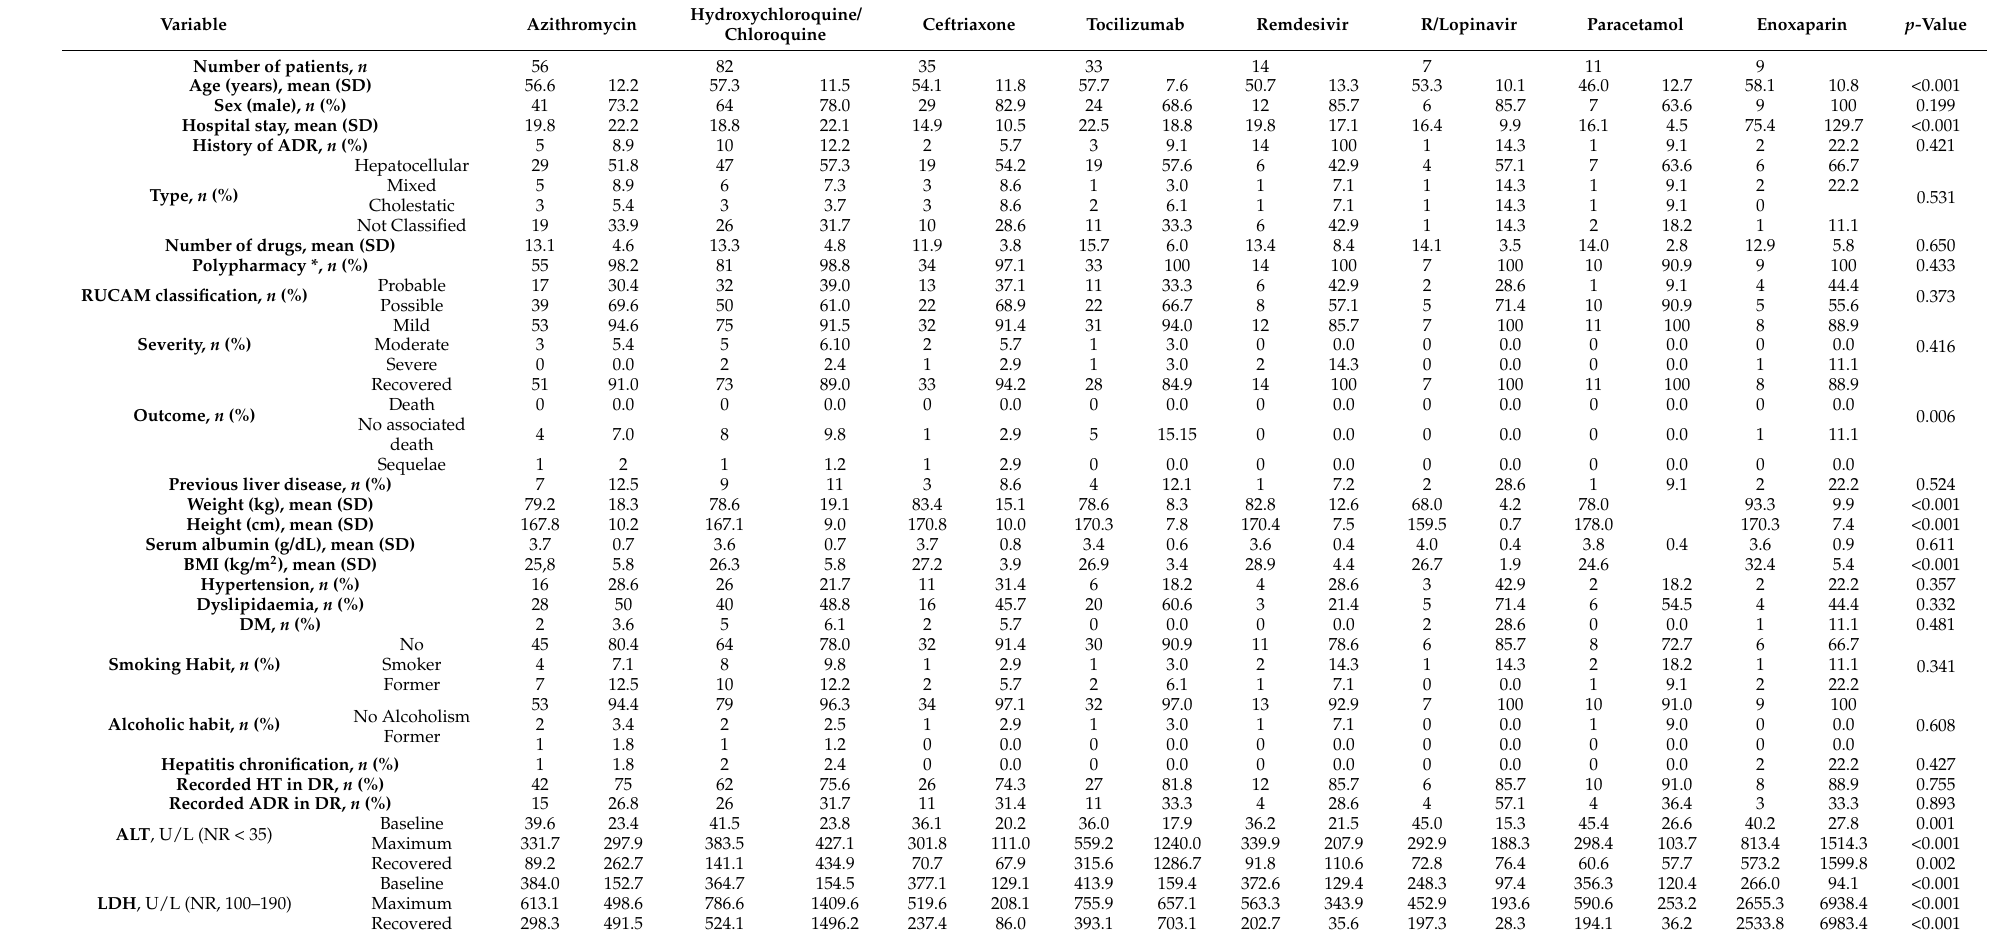
Table 4. Characteristics of DILI cases for the most common drugs (RUCAM score ≥